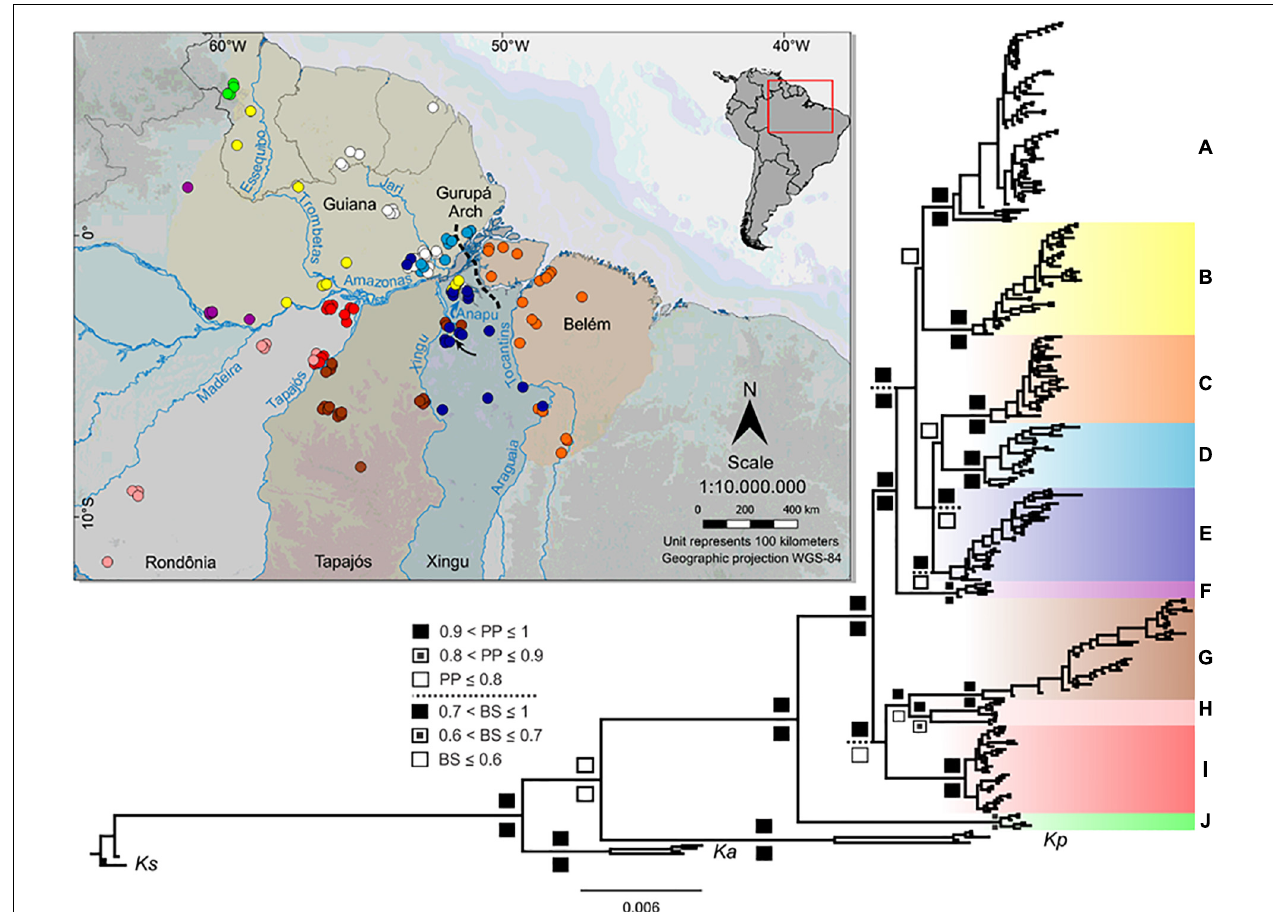
FIGURE 1 | Geographic distribution of Kentropyx calcarata sampled locations used in this study and the concatenated phylogenetic tree (Bayesian inference). Inset with South America map indicates the area shown in the larger map. The dashed line indicates the approximate location of the Gurupá Arch. The black arrow shows the Xingu Great Bend region. Each area of endemism (AoE) is defined by highlighted areas on the map (Guiana AoE is only partially delimited, taking into account the western distribution limit of K. calcarata samples). Circle colors correspond to the clade colors assigned in the phylogenetic tree. Posterior probability-pp (up) and bootstrap-bs (down) values are represented according to the legend in the figure. Bootstrap supports within the main clades were not represented, since the topology of the likelihood tree in these branches differed from the Bayesian tree. External groups correspond to Kentropyx striata (Ks), K. altamazonica (Ka), and K. pelviceps